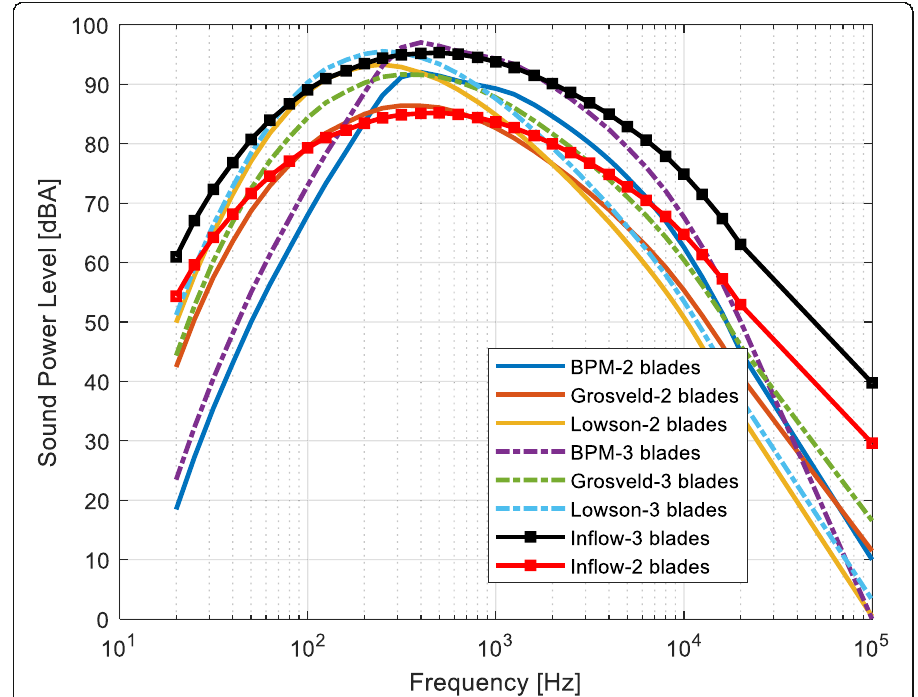
Fig. 10 Computed sound power level for turbulent inflow noise with two and three blade rotors in comparison with turbulent boundary layer trailing edge noise outputs from BPM, Grosveld and Lowson methods at wind speed of U 10 = 10